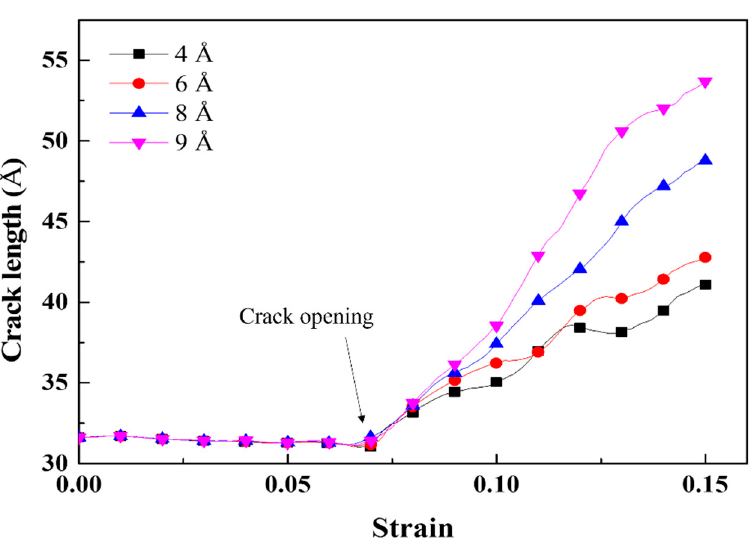
Figure 10. Crack length of the cracked Al containing Mg – Si clusters with radii of 4, 6, 8, and 9 Å as a function of the strain. The lengthening of the crack indicates crack propagation.